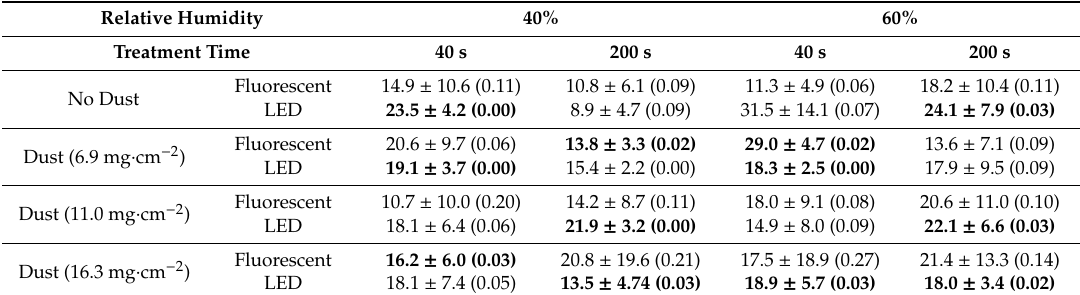
Table A14. O 3 mitigation under the di ff erent dust levels at a relative humidity of 40% and 60% in photolysis. Value in the table report % reduction ± standard deviation ( p -value) and are an average between treatments of NH 3 and H 2 S standard gases. Bold font signifies statistical significance.